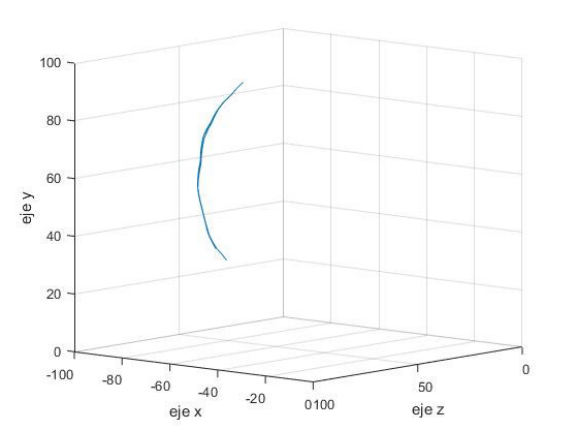
Figure 14. Trajectory of the end-effector of the